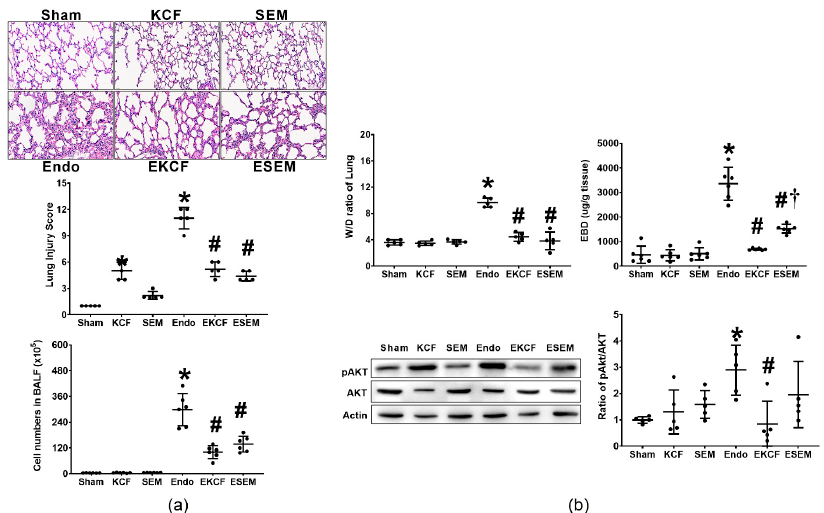
Figure 4. Lung injury status. ( a ) Representative microscopic images of the lung tissues stained with hematoxylin-eosin (200 × ) and the lung injury scores (data were obtained from five mice in each group). The cell numbers in bronchoalveolar fluid (BALF) (the indicator of leukocyte infiltration; data were obtained from six mice in each group). ( b ) Wet/dry weight (W/D) ratio (the indicator of tissue water content; data were obtained from five mice in each group) and Evans blue dye (EBD) concentrations (the indicator of vascular permeability; data were obtained from six mice in each group). The representative gel images of phosphorylated Akt (pAkt), Akt, and actin (the internal standard), and the relative band density of pAkt/actin in lung tissues. Expression of pAKt, Akt, and actin was assayed using immunoblotting assay (data were obtained from five mice in each group). All assays were measured at 24 h after normal saline or endotoxin administration. Sham: the normal saline group. KCF: the normal saline plus the KCF18 peptide group. SEM: the normal saline plus the SEM18 peptide group. Endo: the endotoxin group. EKCF: the endotoxin plus the KCF18 peptide group. ESEM: the endotoxin plus the SEM18 peptide group. Data were presented as the mean ± standard deviation. * p < 0.05, versus the Sham group. # p < 0.05, versus the Endo group. † p < 0.05, the ESEM group versus the EKCF group.